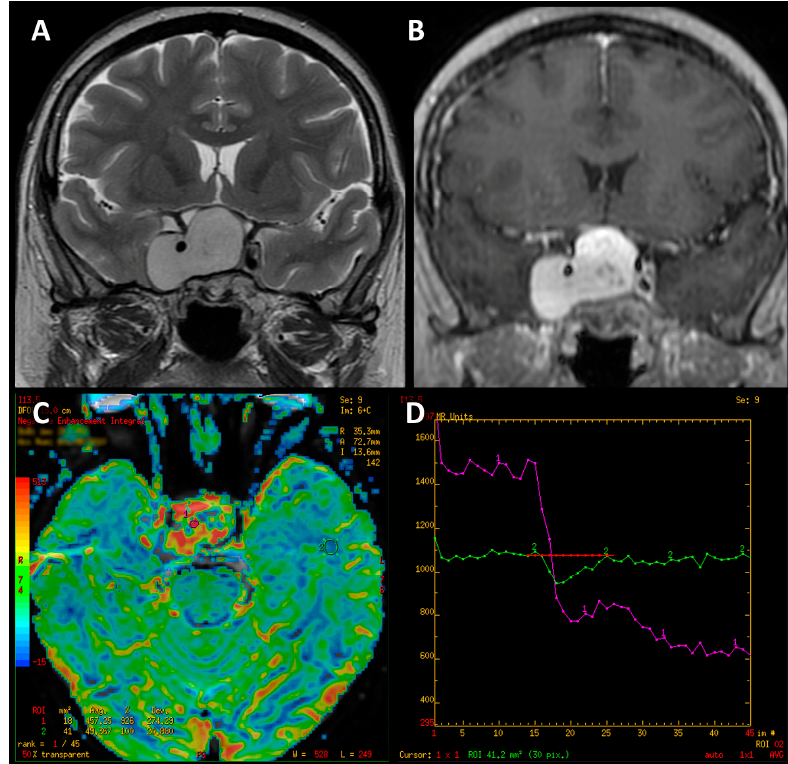
Figure 9. Coronal T2-weighted image of hemangioblastoma ( A ). Contrast-enhanced T1-weighted coronal image ( B ). Color-coded map of cerebral blood volume with the ROI placed in normal-ap- pearing white ma tt er ( C ). T2* signal intensity curve of hemanagioblastoma (purple line), which ini- tially shows an apparent return to the baseline and declines again afterwards ( D ).